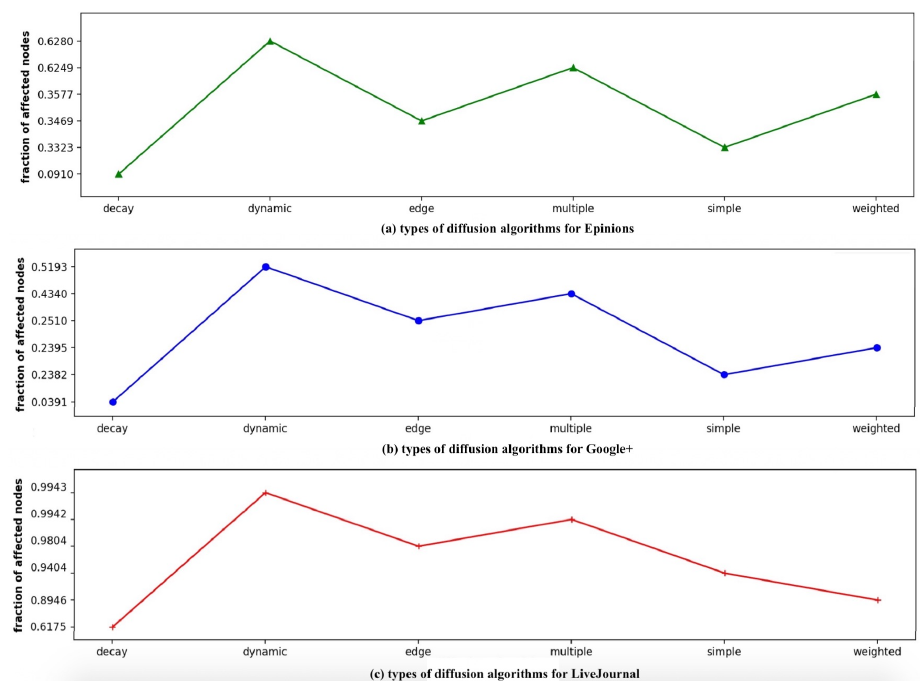
Figure 9. A comparison of the performances of six diffusion algorithms for all the three datasets: ( a ) Epinions; ( b ) Google+; and ( c )